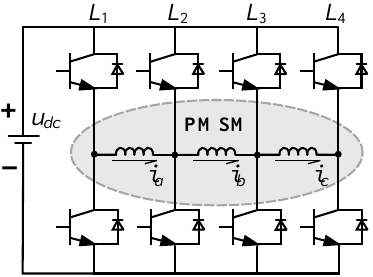
Figure 1. Open-winding topology for a three-phase PMSM drive.